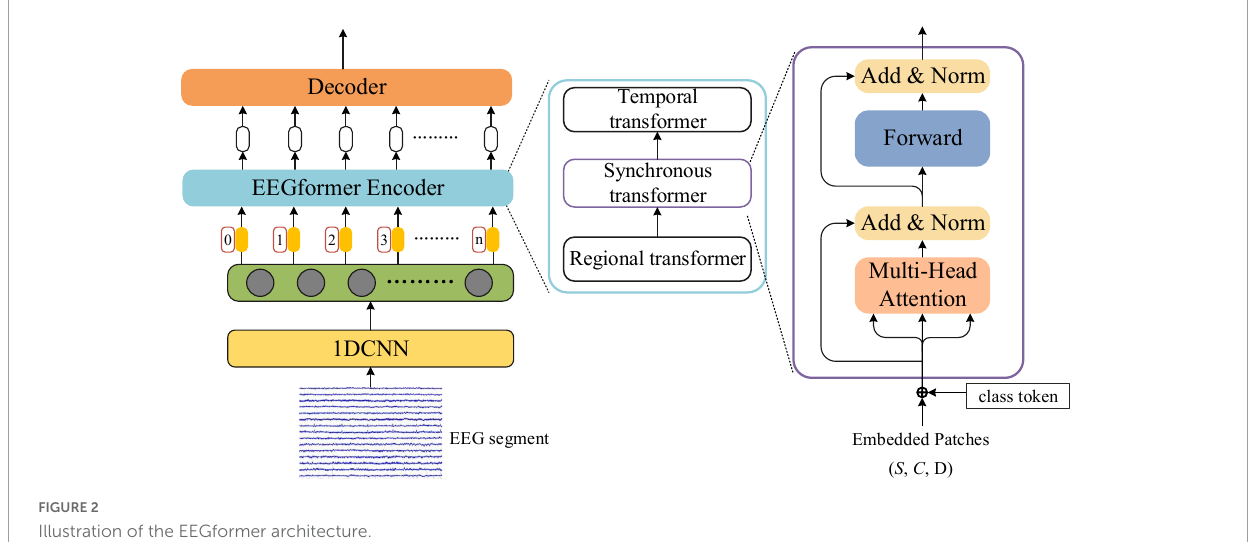
FIGURE2 Illustration of the EEGformer